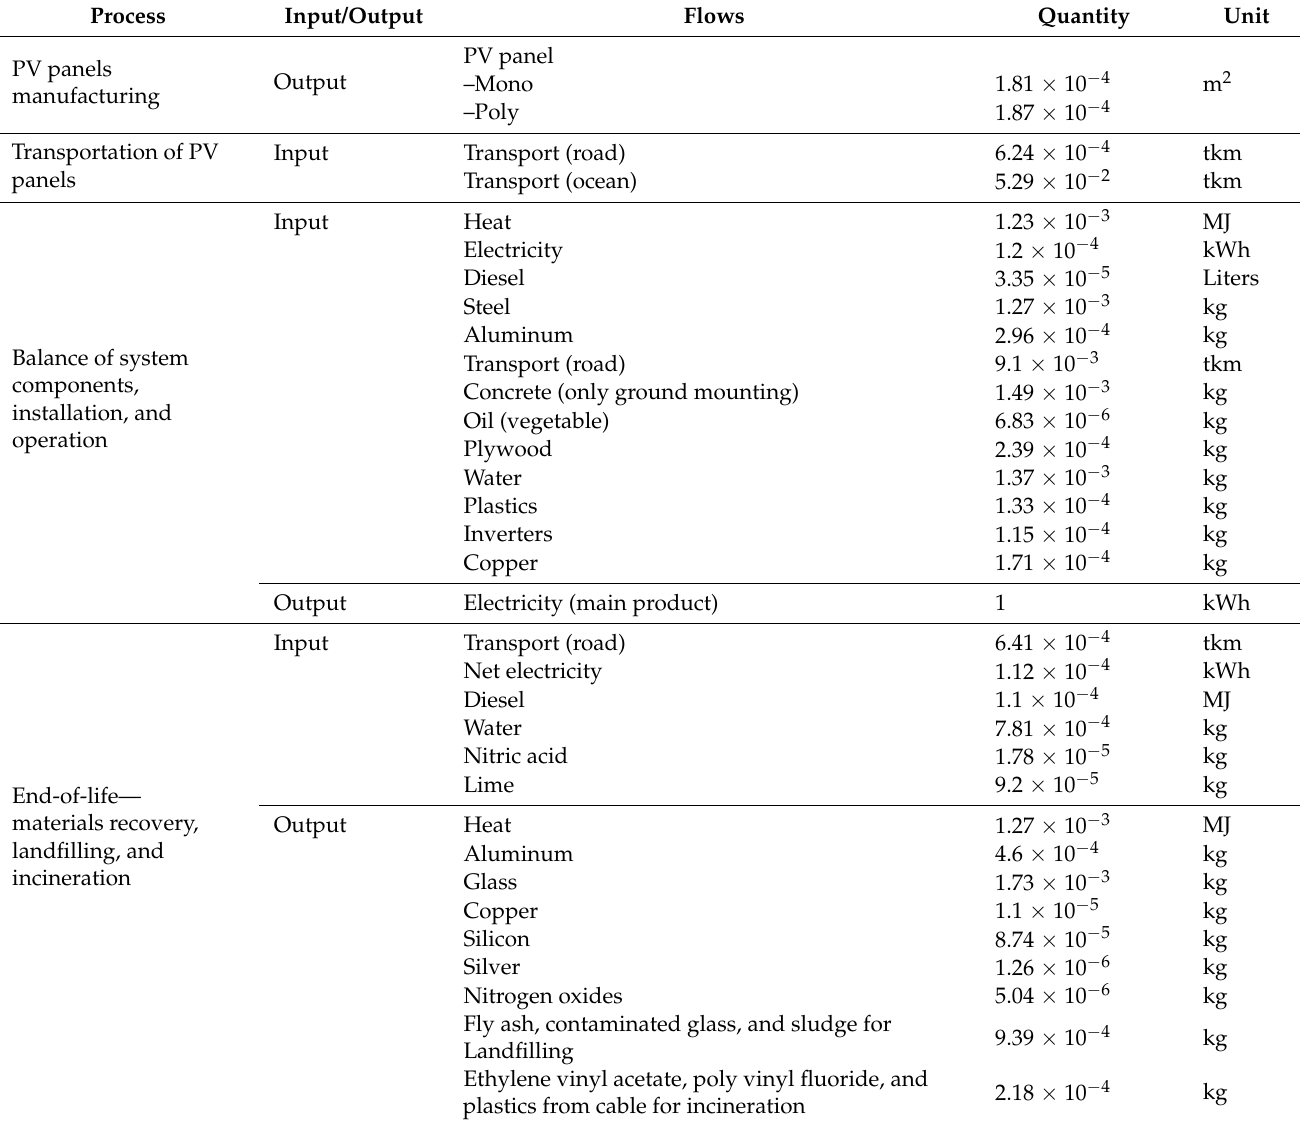
Table 2. Summary of major flows of materials and energy per functional unit (1 kWh) aver- aged over the 120 sites for solar panel manufacturing, transportation, balance of systems, and end-of-life